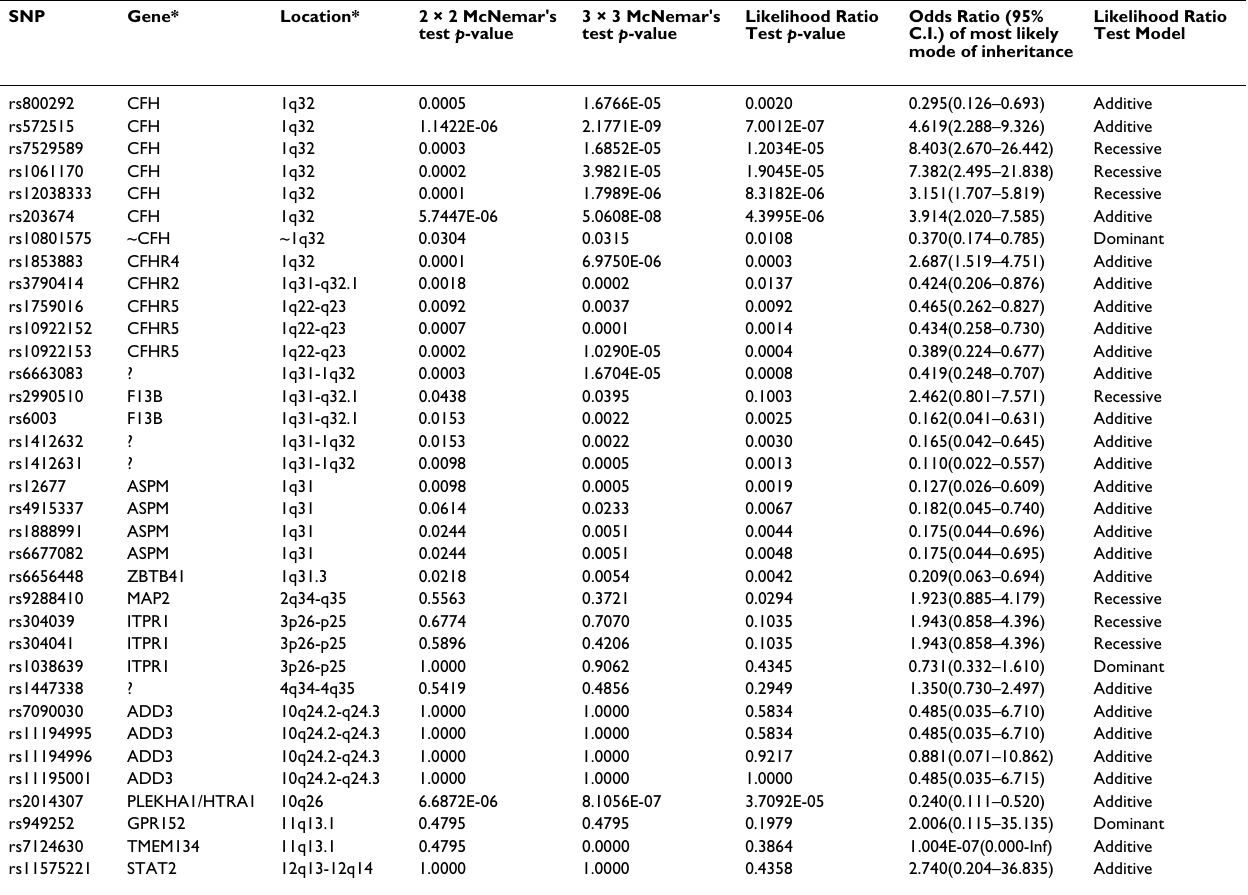
Table 1: Single SNP Analysis SNP